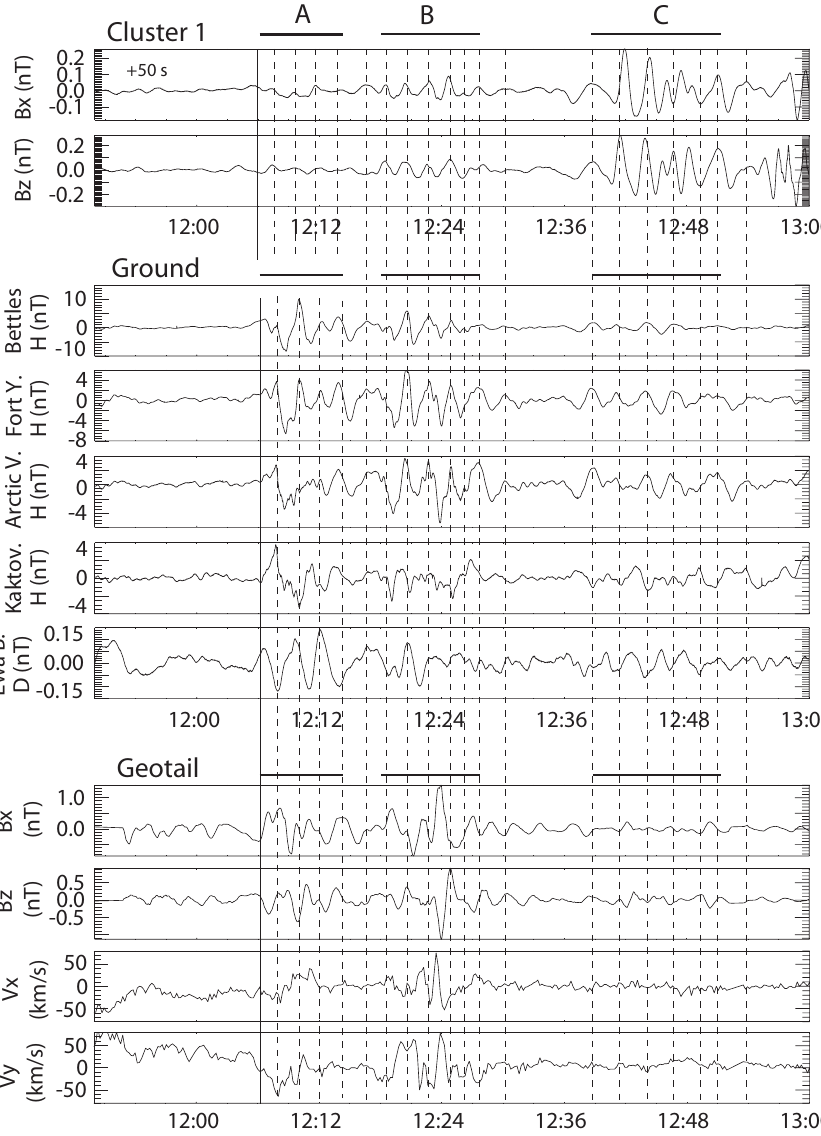
Fig. 8. Comparison of Cluster data, ground data, and Geotail data during the events on 24 August 2001. All data were band-pass filtered (40s, 150s) except the flow data of Geotail (last two panels). The ground data are from GIMA stations: Bettles ( L =6.35), Fort Yukon ( L =6.2), Artic Village ( L =6.47), Kaktovik ( L =7.5), and the 210MM station: Ewa Beach ( L =1.6). Note that B x of Cluster is shifted by